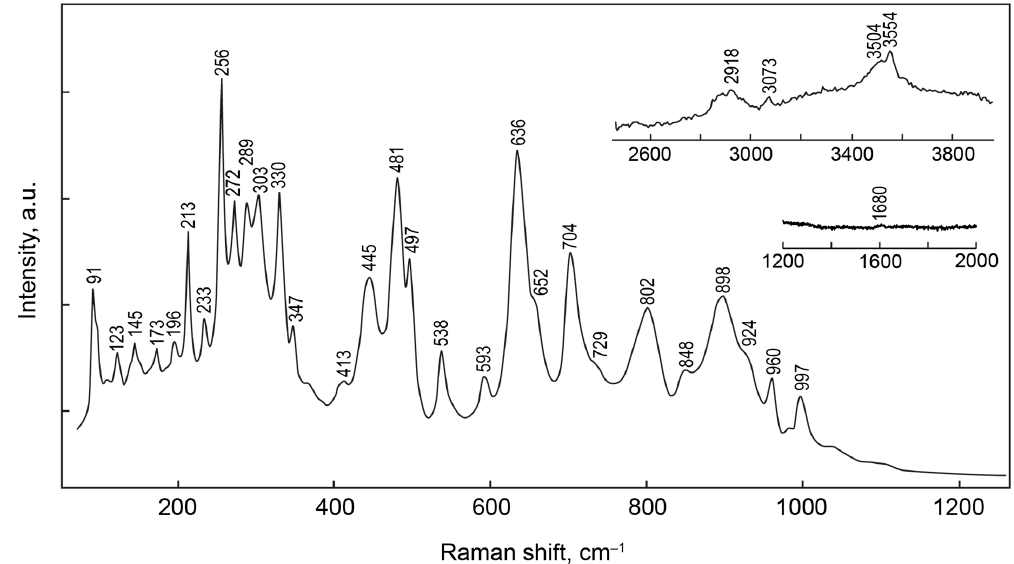
Figure 4. Raman spectrum of chirvinskyite. The spectrum intensity at 2600–3900 and 1200–2000 cm − 1 is enlarged by two.